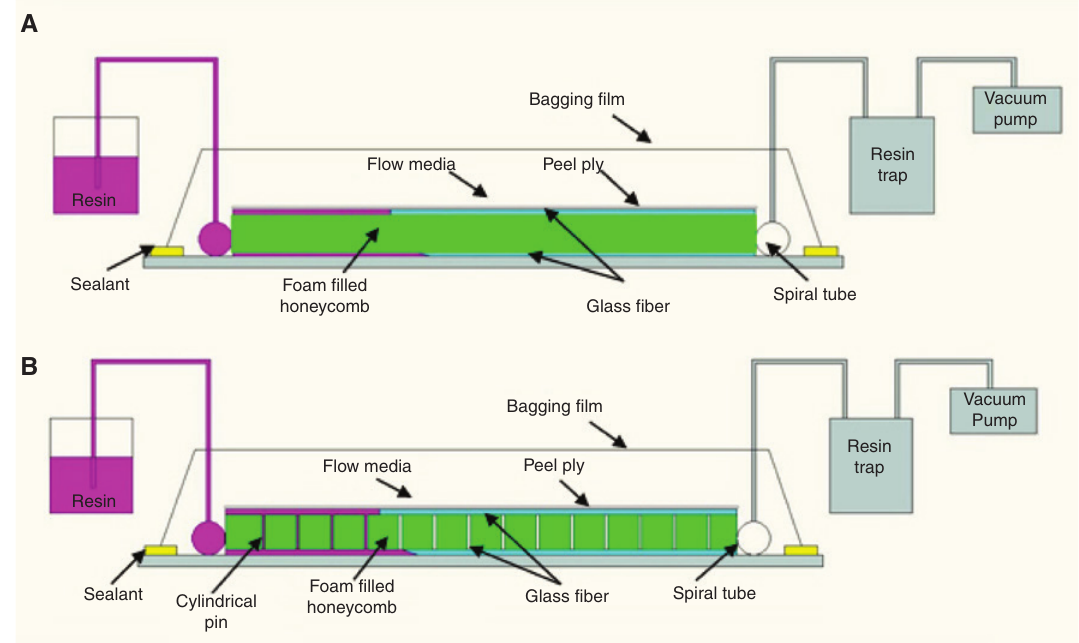
Figure 1: Schematic showing the difference in fabrication of (A) FHS panel and (B) PFHS panel by vacuum infusion process.